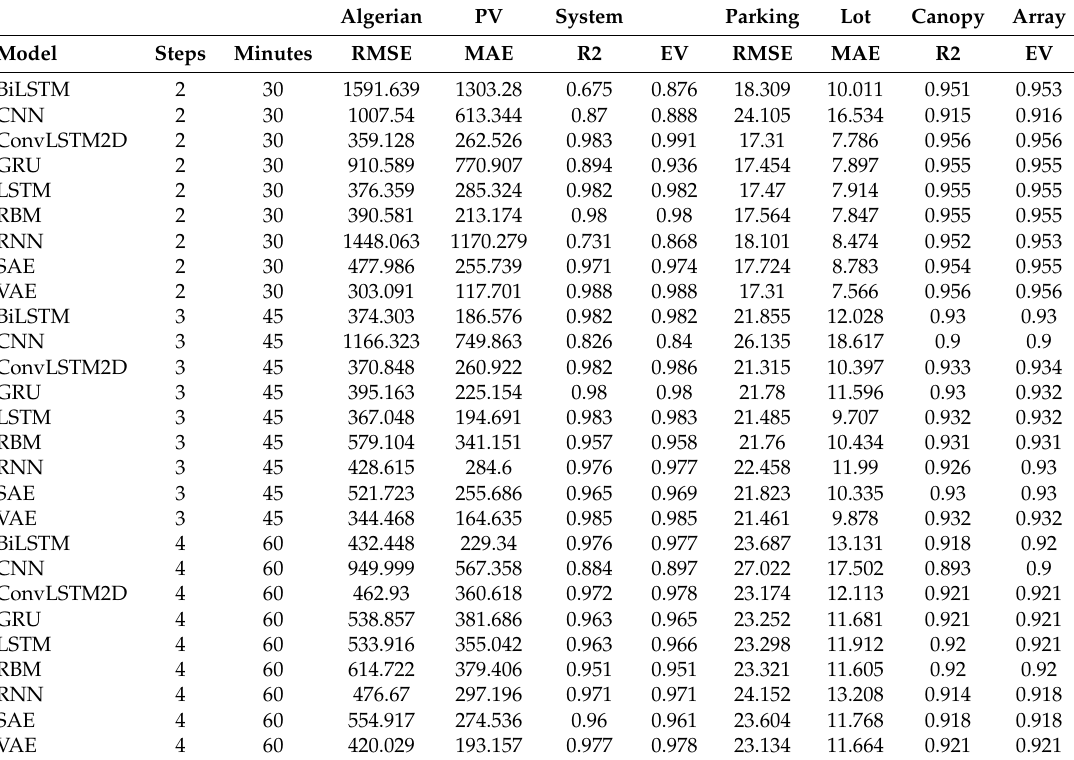
Table 5. Validation metrics for multistep-step-ahead